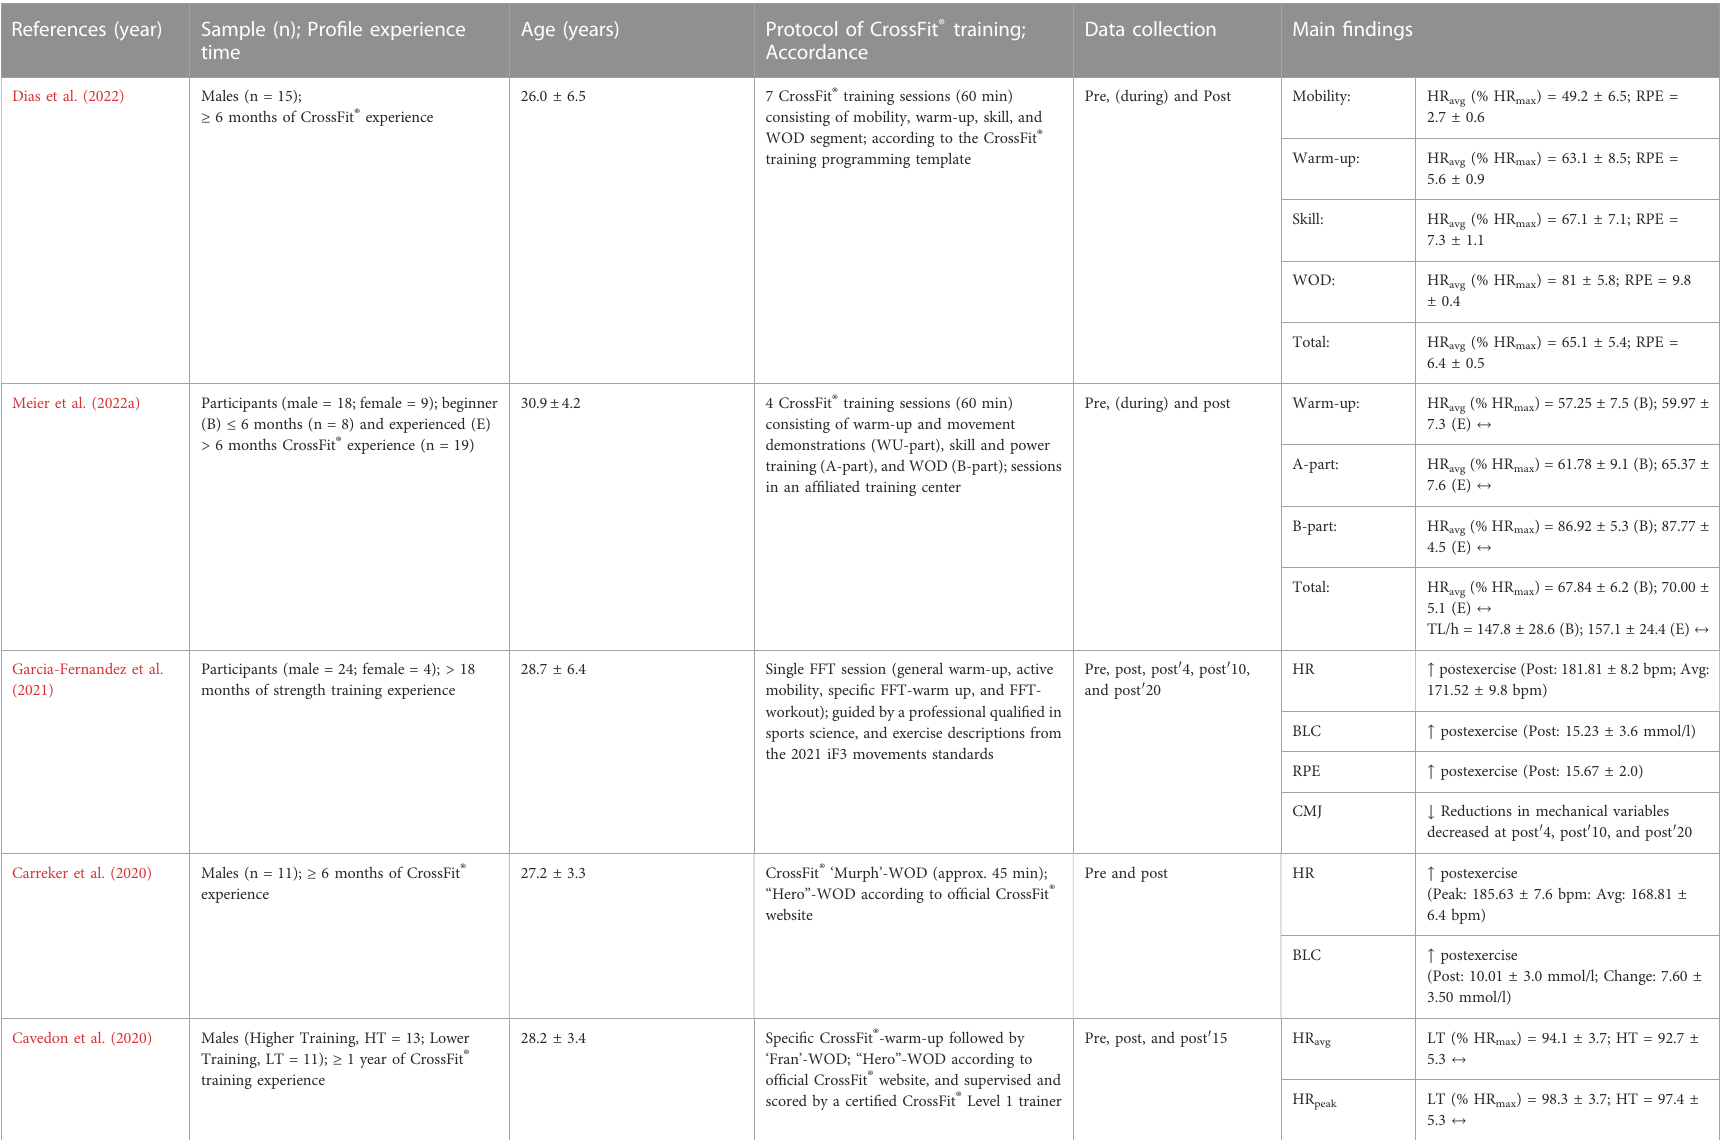
TABLE 2 Part A: Acute, Short-term Physiological Responses of CrossFit ®